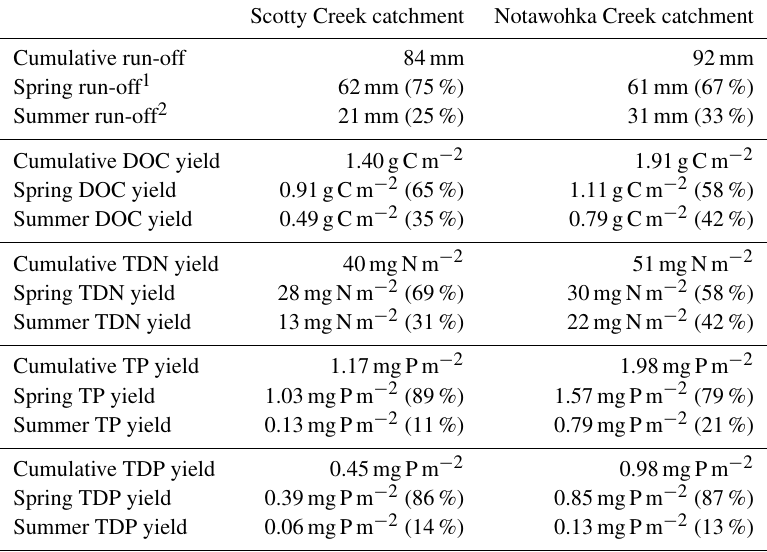
Table 1. Cumulative run-off and solute yield from Scotty Creek and Notawohka Creek catchments during the 2016 study